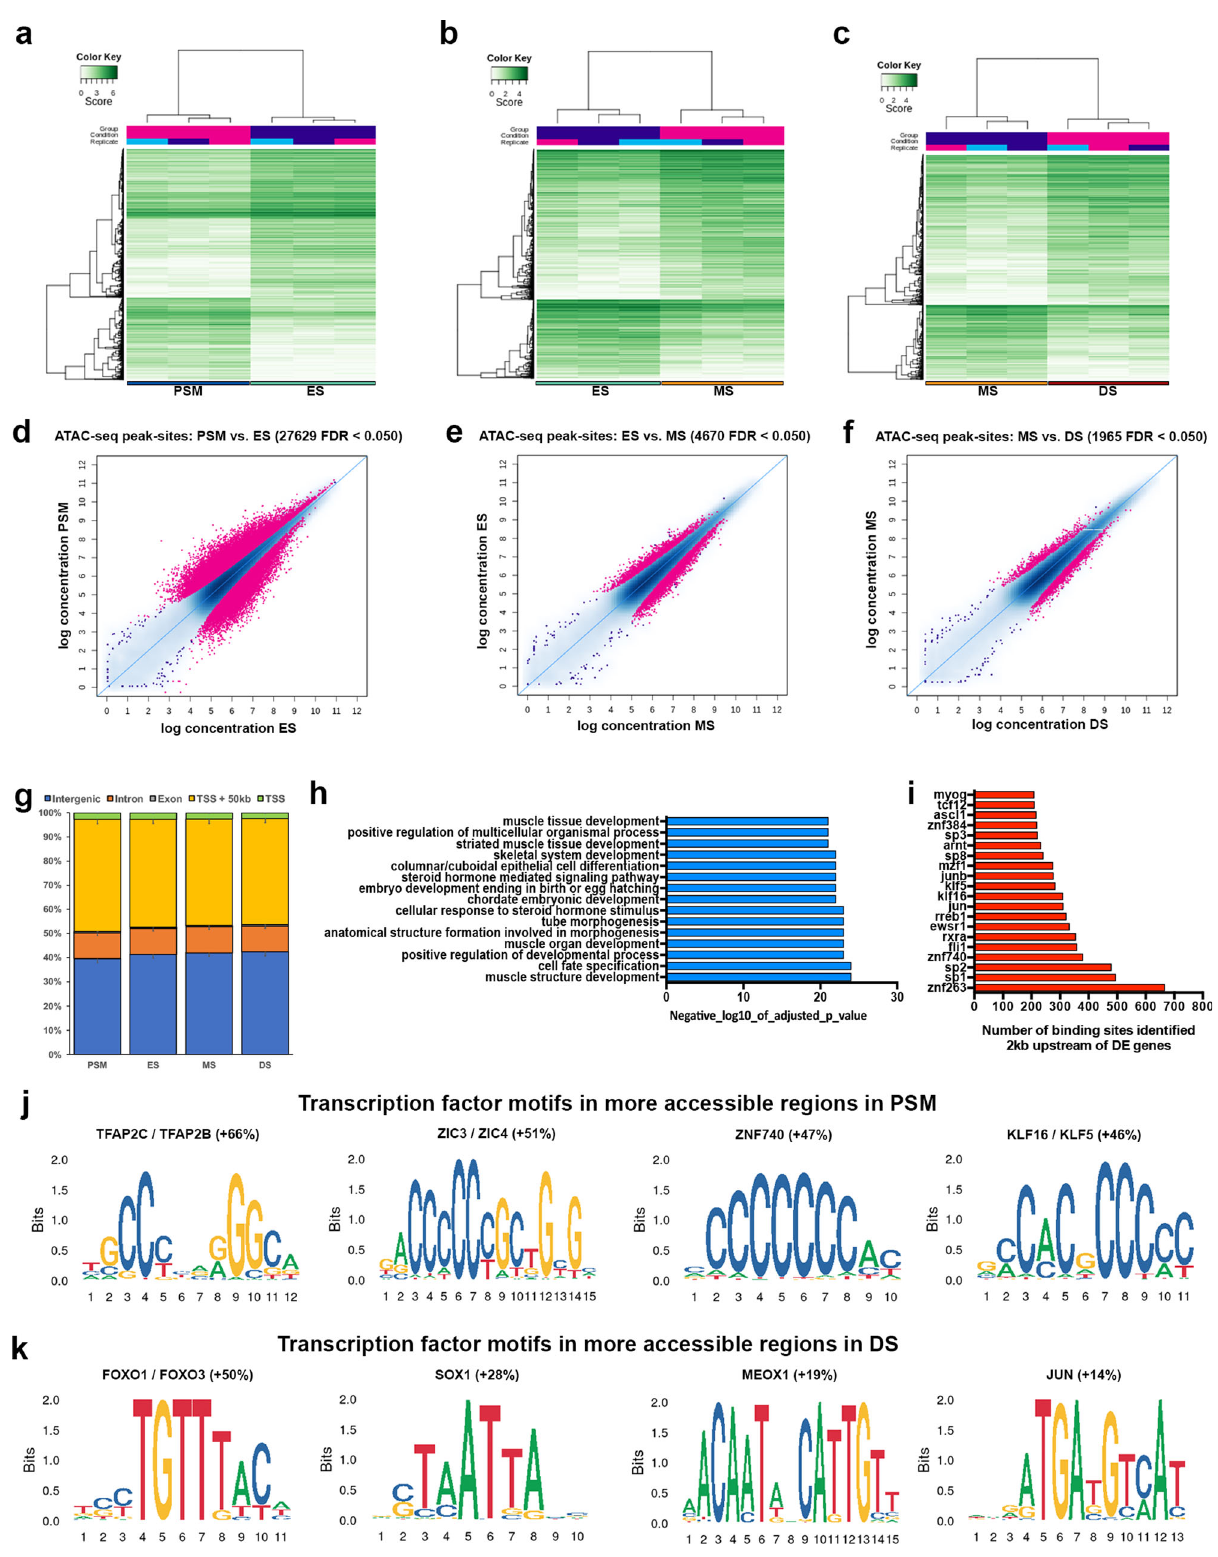
Fig. 3i). HINT-ATAC identi fi ed fewer RARA footprints in PSM compared to MS and DS (Supplementary Fig. 3k, l). The inverse coverage patterns identi fi ed for CDX2, LEF1 versus RARA were consistent with the opposing expression patterns for WNT and RA pathway components within paraxial mesoderm along the anterior – posterior axis (Fig. 1g). To further dissect